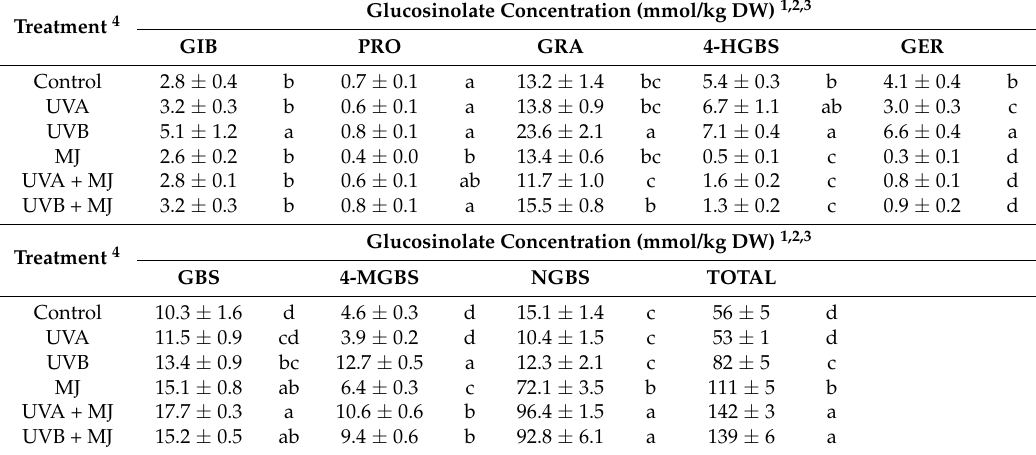
a Major fragment ions are highlighted in bold. Table 2. Concentration of individual and total glucosinolates in broccoli sprouts treated with UVA or UVB light, methyl jasmonate or a combination of